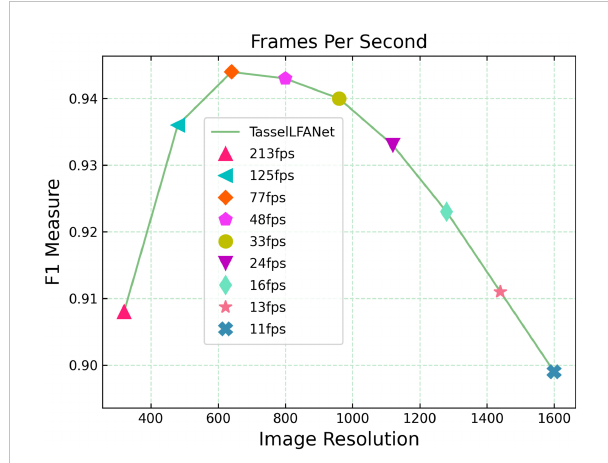
FIGURE 6 Relationship between image resolution, F1-measure and frames per second (FPS) in image